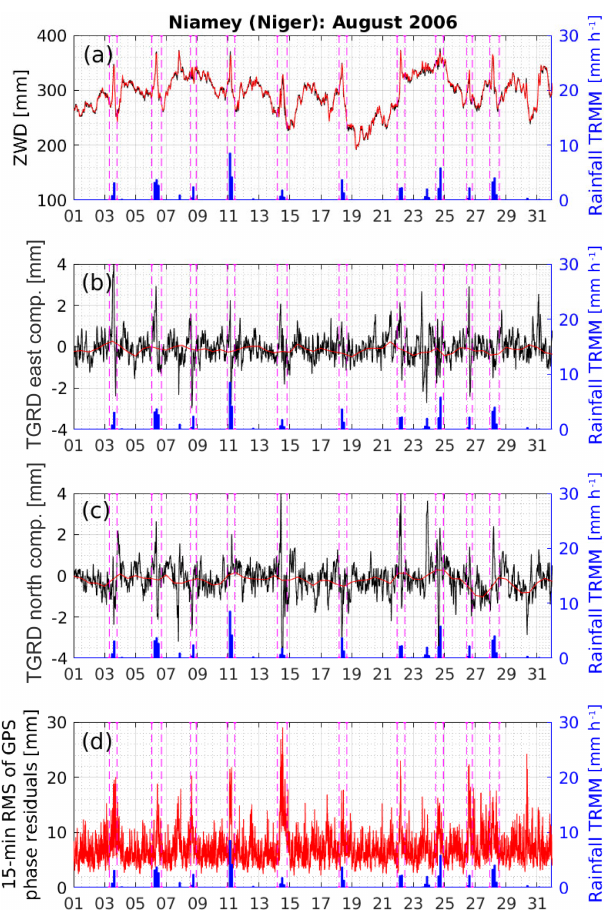
Figure 13. Composites of surface air (a) temperature ( ◦ C), (b) rel- ative humidity (%), and (c) pressure (hPa) from the in situ PTU200 sensor, and (d) the ZWD (mm), (e) east components of the tropo- spheric delay gradient, and (f) north components of the tropospheric delay gradient (mm) at all six AMMA stations, in a 10h window centered on the cold pool crossing time